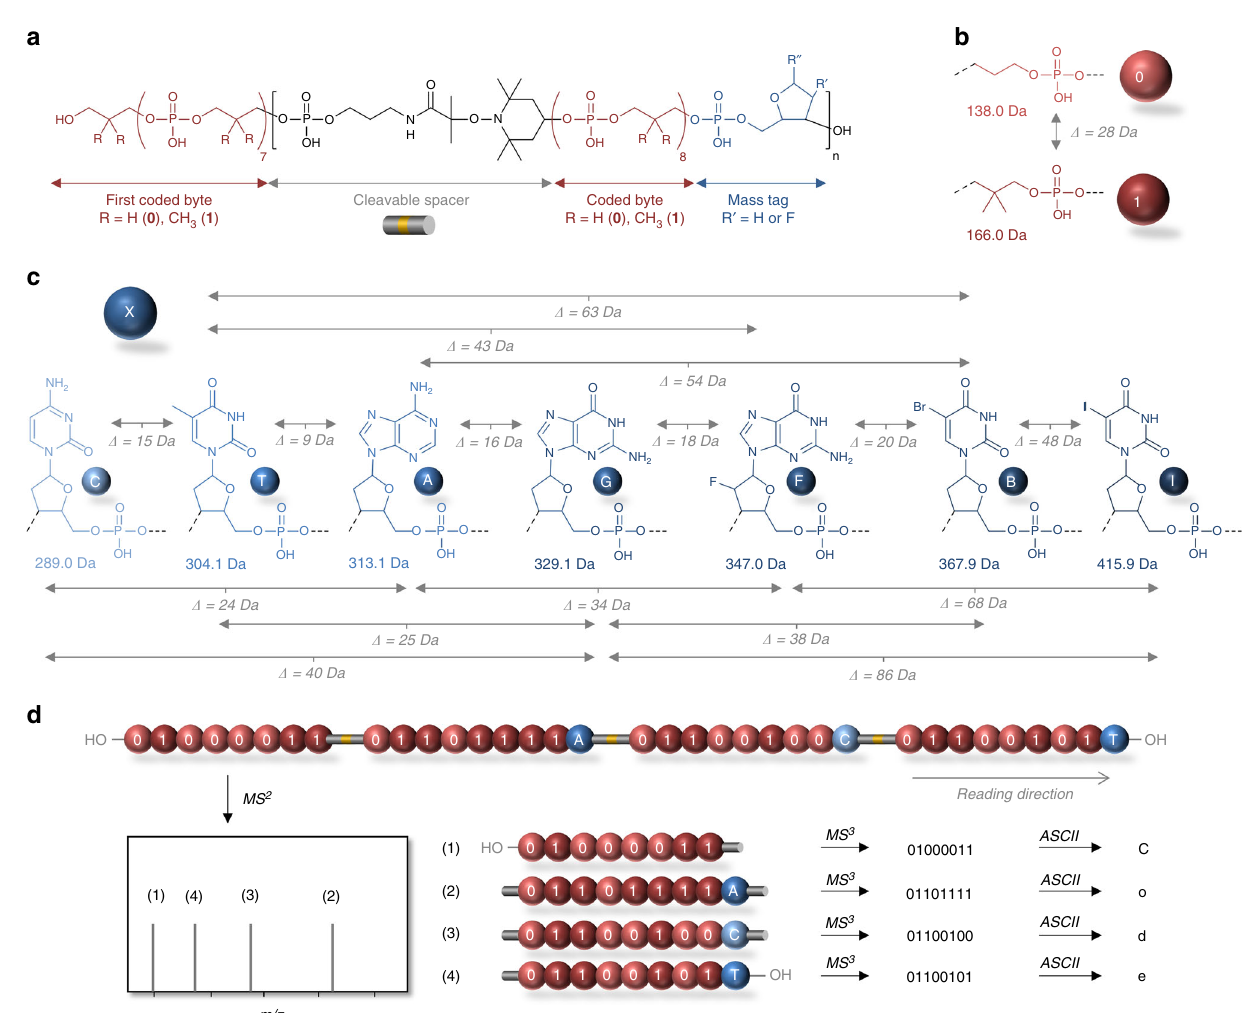
Fig. 1 General concept studied herein for the sequencing of long digital polymer chains. a Molecular structure of the sequence-coded polymers prepared by automated phosphoramidite chemistry. These digital polymers contain n + 1 coded bytes noted in red. A byte is a sequence of eight coded monomers that represent 8 bits. Two consecutive bytes are separated by a linker noted in black, which contains a NO-C bond that can be preferentially cleaved during MS/ MS analysis. In order to sort out the bytes after MS/MS cleavage, n bytes of the sequence are labeled with a mass tag noted in blue. b Molecular structure and mass of the two coded synthons that de fi ne the binary code in the polymers. c Molecular structure and mass of the mass tags that are used as bytes labels. In order to induce identi fi able mass shifts after MS/MS cleavage, the mass of a byte tag (noted in blue) shall not be a multiple of 28, which is the mass difference between a 0 and a 1 coded unit. In addition, the mass difference between two tags (noted in grey) shall not be a multiple of 28. d Schematic representation of the mass spectrometry sequencing of a digital polymer containing 4 bytes of information. The polymer is fi rst analyzed in MS/ MS conditions, which lead to the favored cleavage of the weak NO-C bonds (depicted in yellow inside the grey spacers). Since they carry mass tags, the resulting cleaved bytes are sorted out by mass in the MS/MS spectrum (the displayed MS 2 cartoon is idealized for clarity). Afterwards, each byte can be easily sequenced in MS 3 conditions and the whole binary sequence can be deciphered